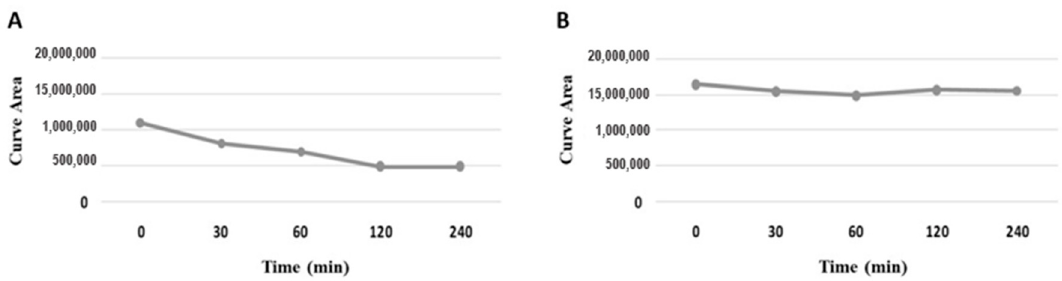
Figure 8. Chemical stability of LASSBio − 1920 at pH 2 ( A ) and 7.4 ( B ). Second, GIT (Table 7) and BBB (Table 8) permeability assays were performed for LASSBio-1920, considering its possible oral and systemic use. Taken together, the data obtained indicate that the test compound will be able to cross the BBB and reach the CNS (Pe = 11.48). In addition, it has a high predictive absorption fraction (99.7%) for the gastrointestinal tract. Table 7. Absorbed fraction of LASSBio-1920 and controls obtained by the PAMPA-GIT technique. Compound Fa (Literature) Pe (Experimental) Atenolol